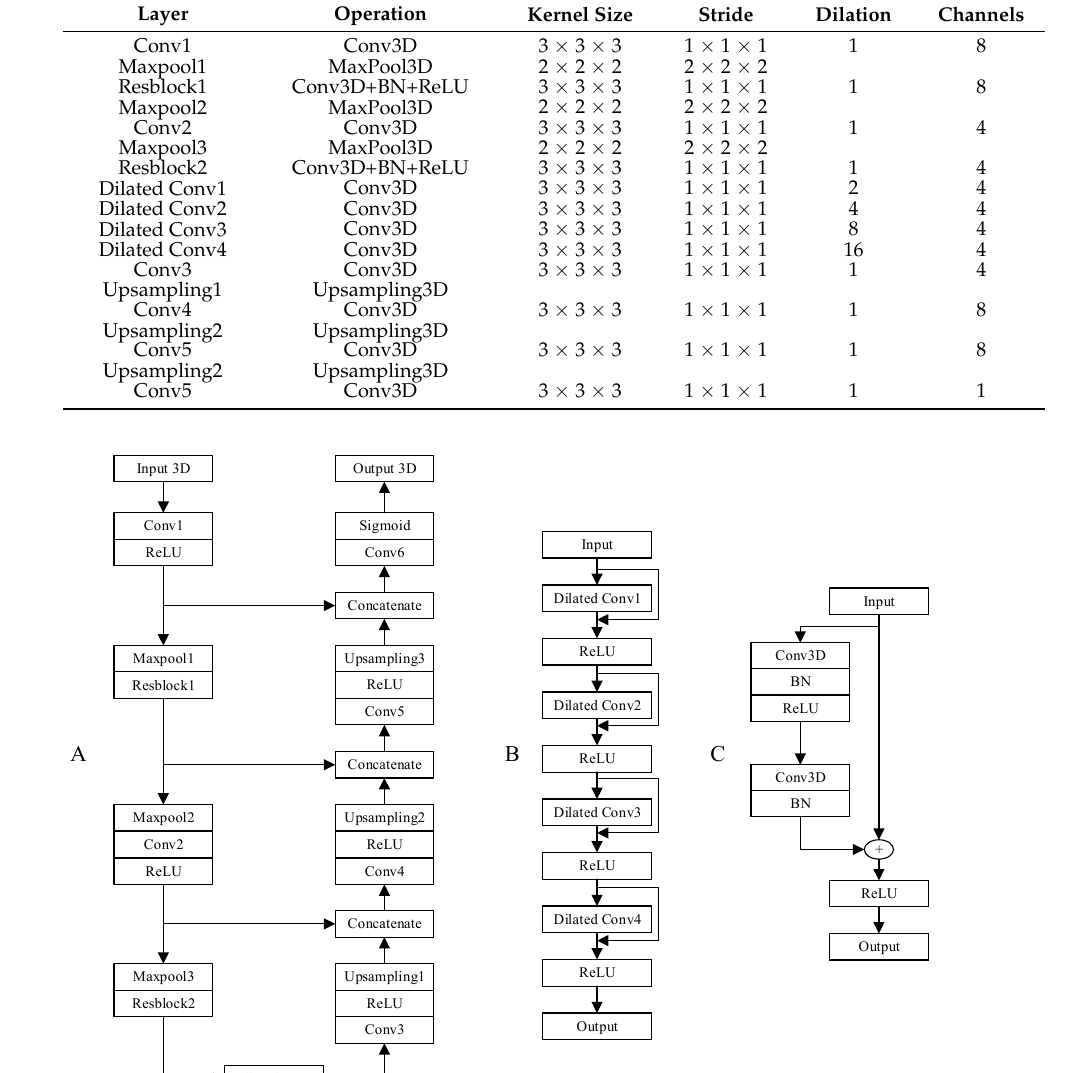
Table 1. Network parameters.